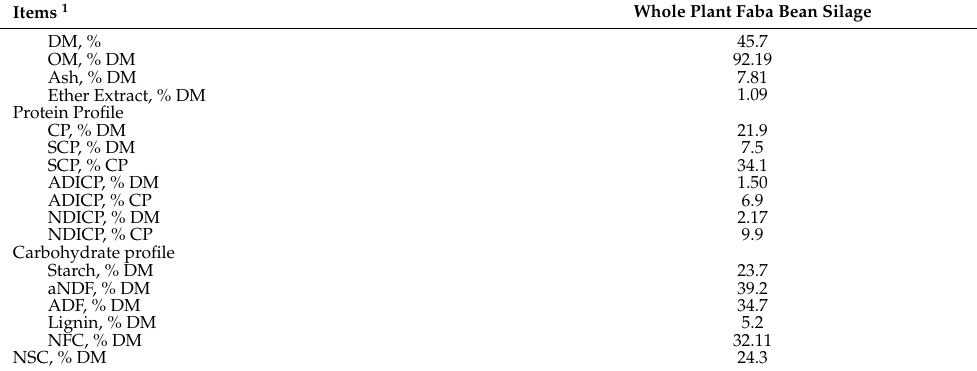
Table 1. Chemical composition of whole plant faba bean